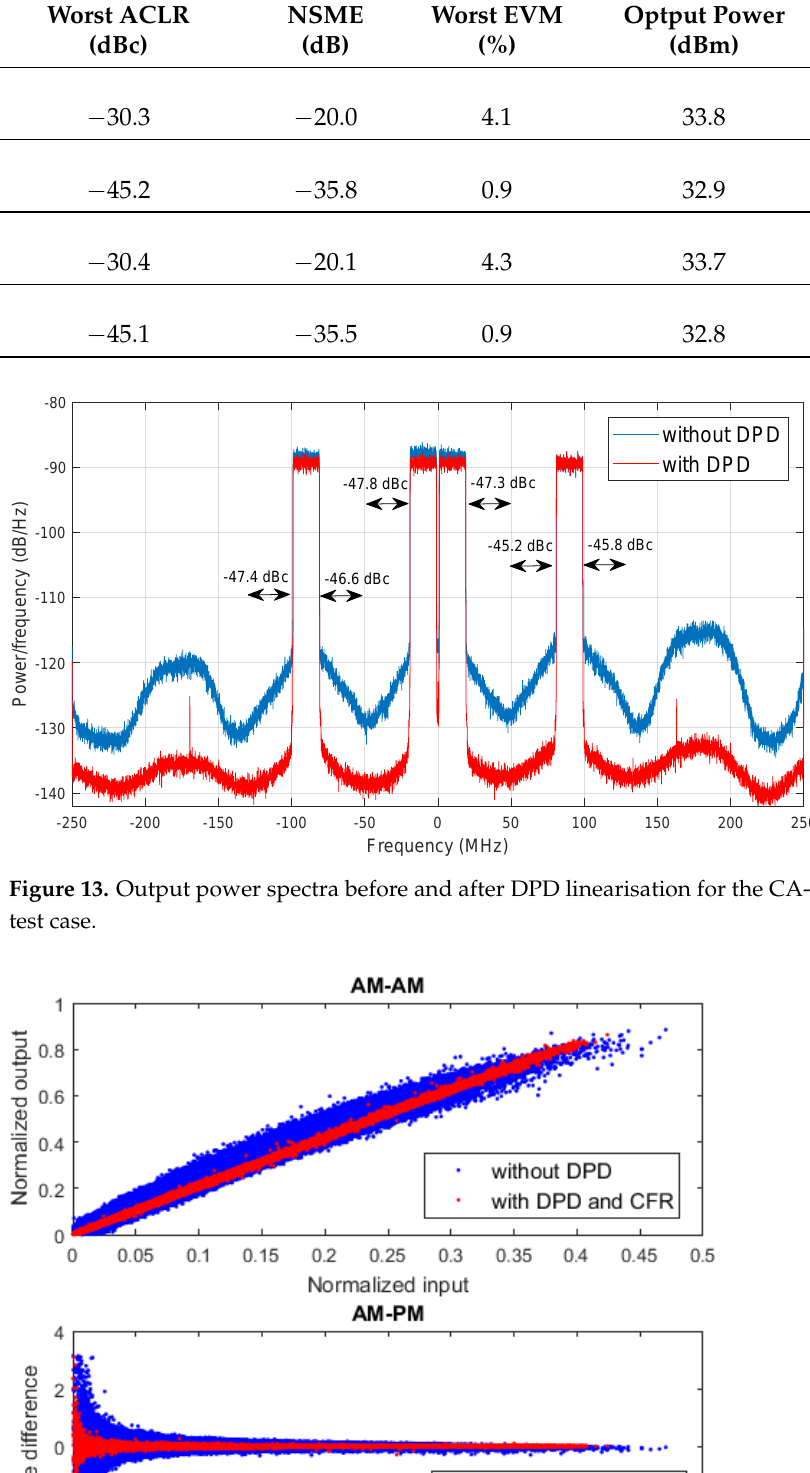
Table 4. Linearisation results with the CA-4 × LTE-20 200 MHz bandwidth signal. Opt. Config.